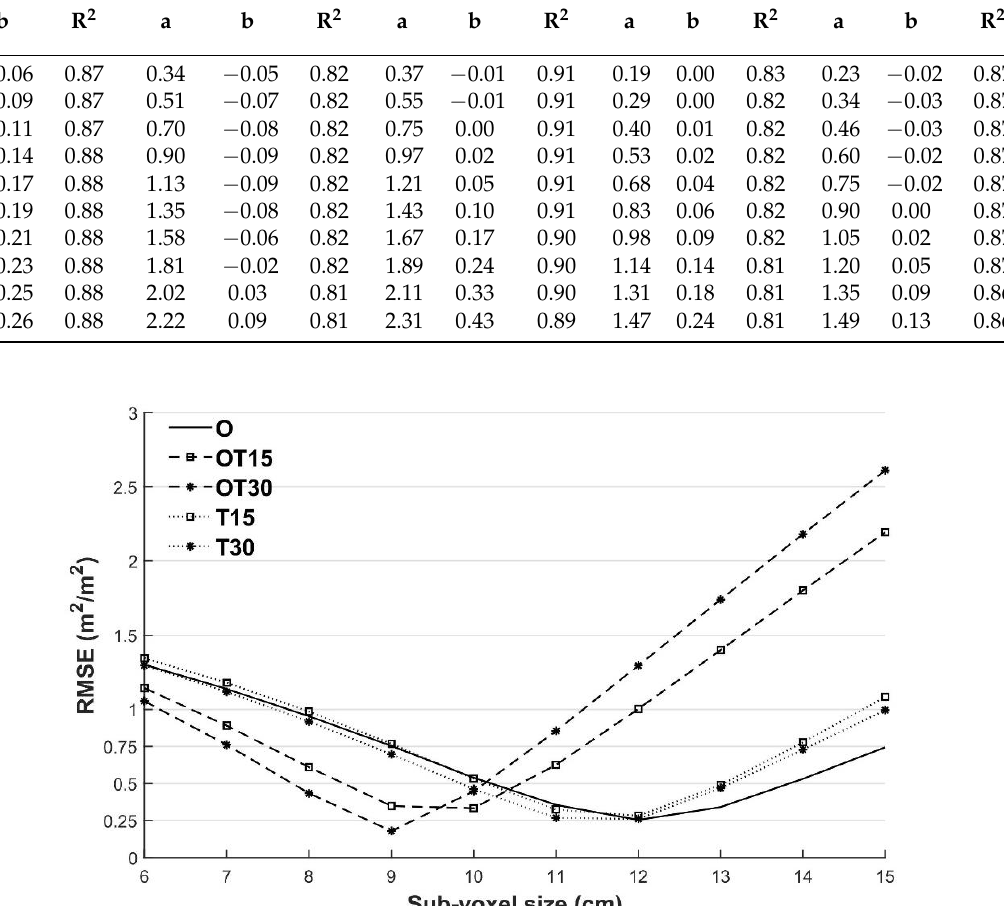
Figure 9. The best LAI estimation scheme for each of the five schemes, under different sub-voxel sizes. Sub-voxel size when the LAI of the five schemes was the best: O (0.12 m); OT15 (0.10 m); OT30 (0.09 m); T15 (0.12 m); T30 (0.12 m).